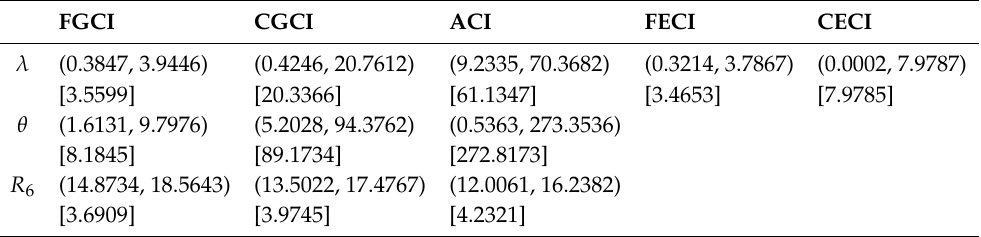
Table 5. Interval and prediction interval estimates using the lung cancer survival data (8). FGCI CGCI ACI FECI CECI λ